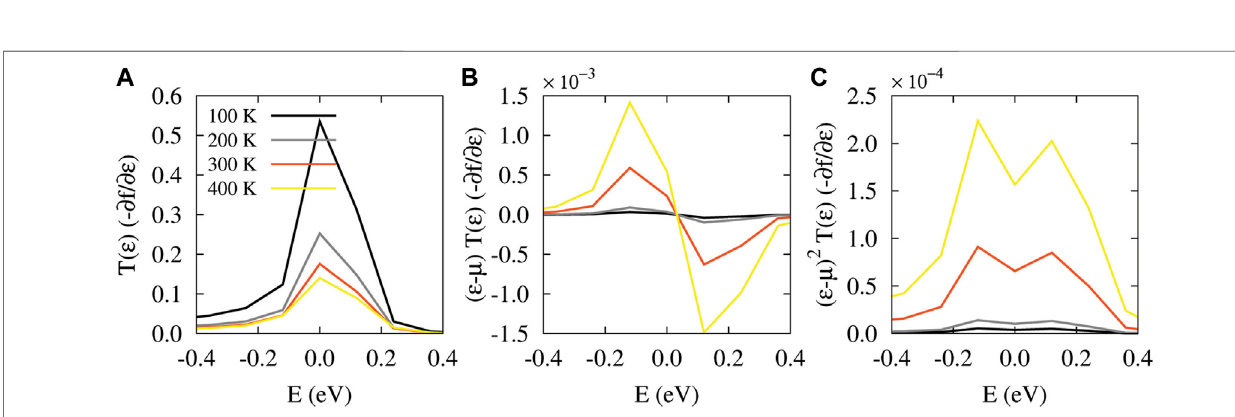
FIGURE3| ThetemperaturedependencyofLorenzfunctionsisexamplarydrawnfortheunperturbedmolecularjunctionterminatedwiththethiolanchoringgroup. (A) T ( ε ) ( − z f / z ε ). (B) ( ε − μ ) T ( ε ) ( − z f / z ε ). (C) ( ε − μ ) 2 T ( ε ) ( − z f / z ε